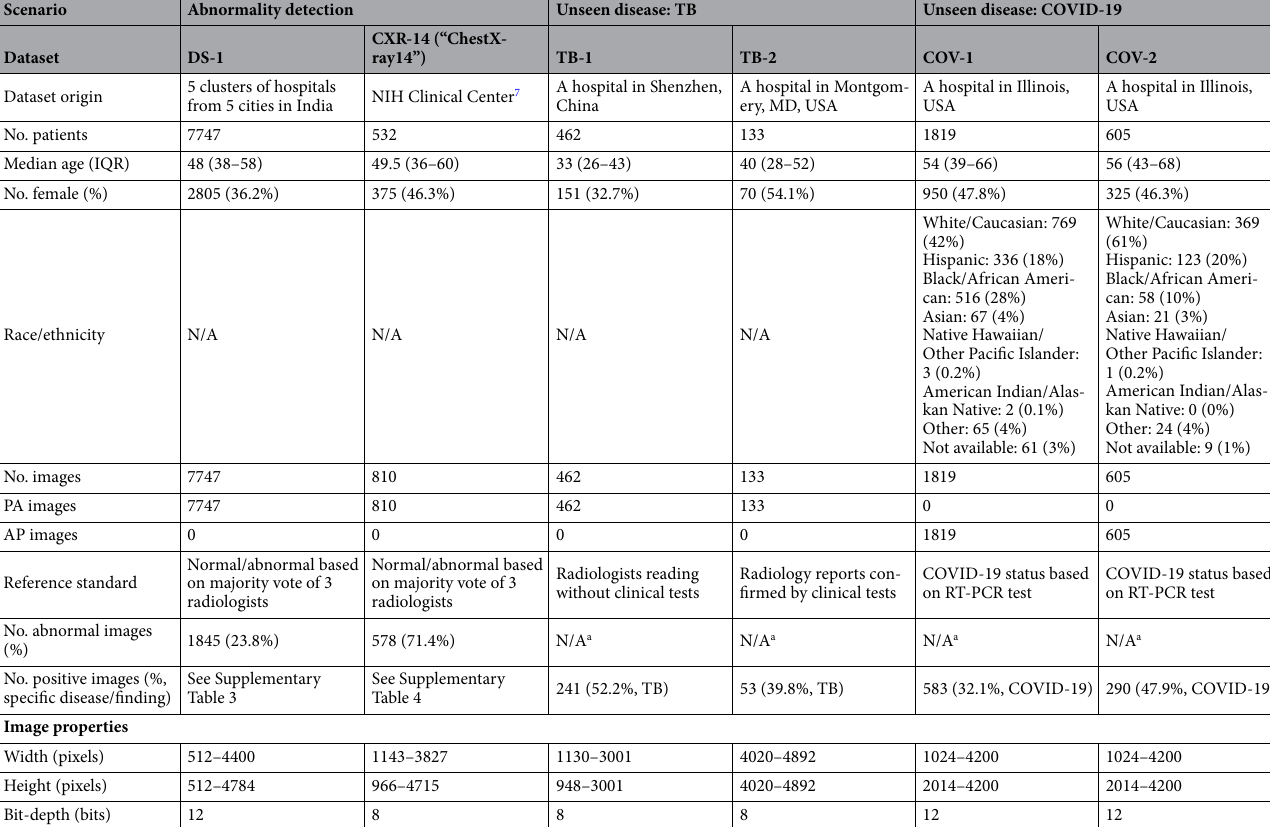
Table 1. Data and patient characteristics of the 6 test datasets. N/A indicates information was not available. a Abnormal images in the disease-specific datasets include both those positive for TB or COVID-19, and those with other findings; the numbers of images that contained other findings were not